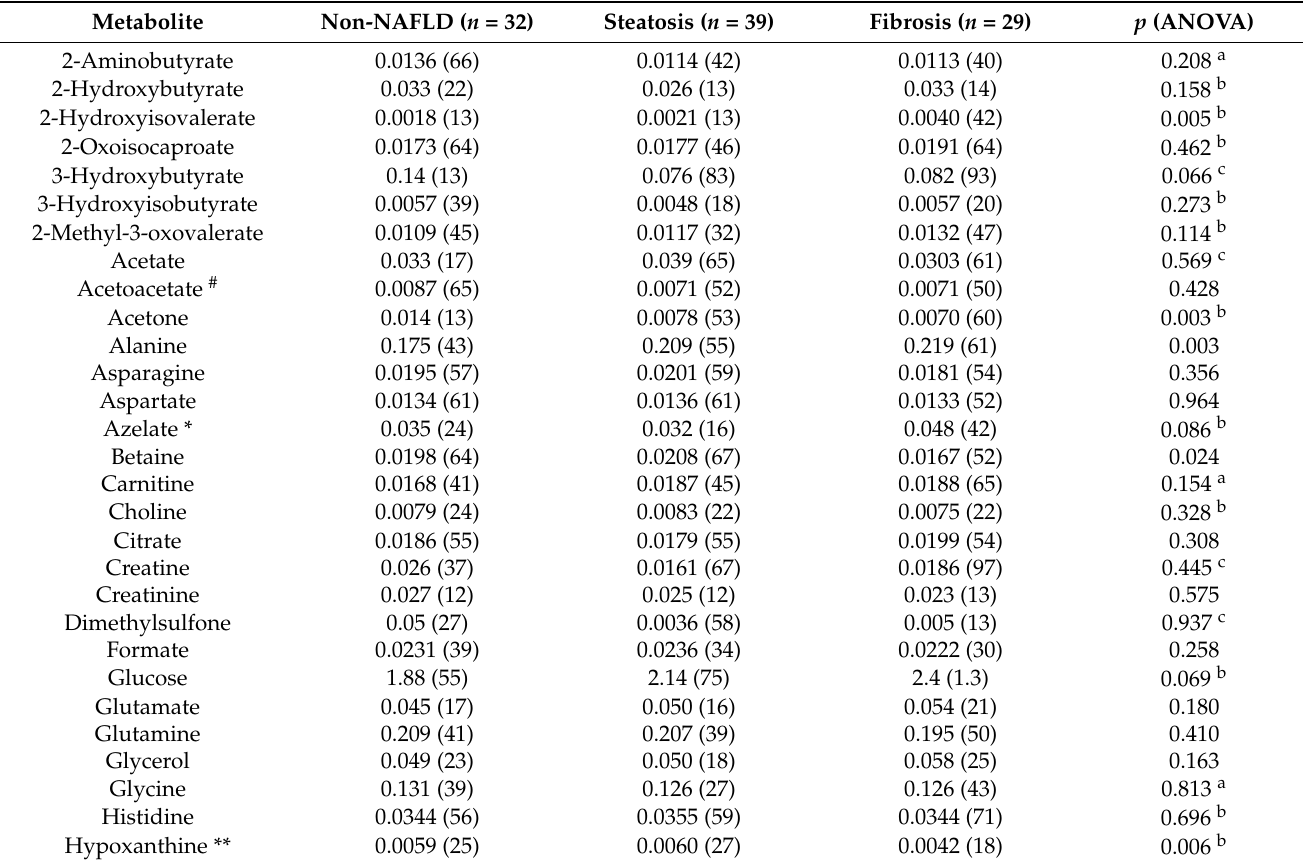
Table 2. Mean metabolite values, standard deviations, and one-way ANOVA significance values for 49 metabolites measured by 1 H NMR (600 MHz; Chenomx 8.1) in the extracted sera (mM) across all three groups are listed. Multiply values by 2 to obtain the serum concentration. Two digits are retained in the standard deviation (SD) and the means rounded to the final decimal place dictated by the SD. Standard deviations in parentheses apply to the last digits of the mean, i.e., 0.1234 (56) means 0.1234 ±